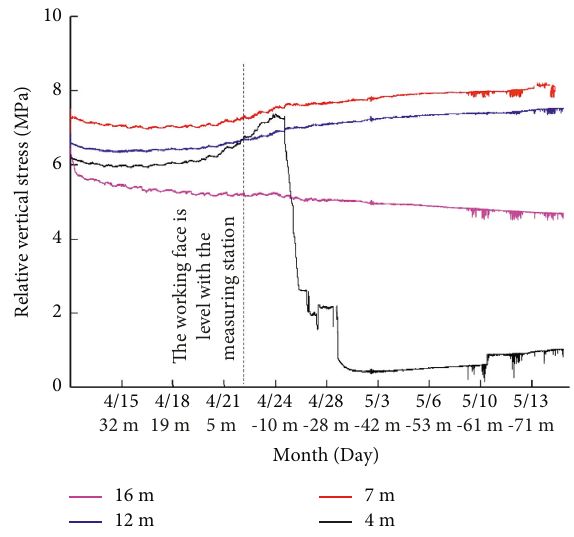
Figure 6: Variation curve of relative vertical stress of